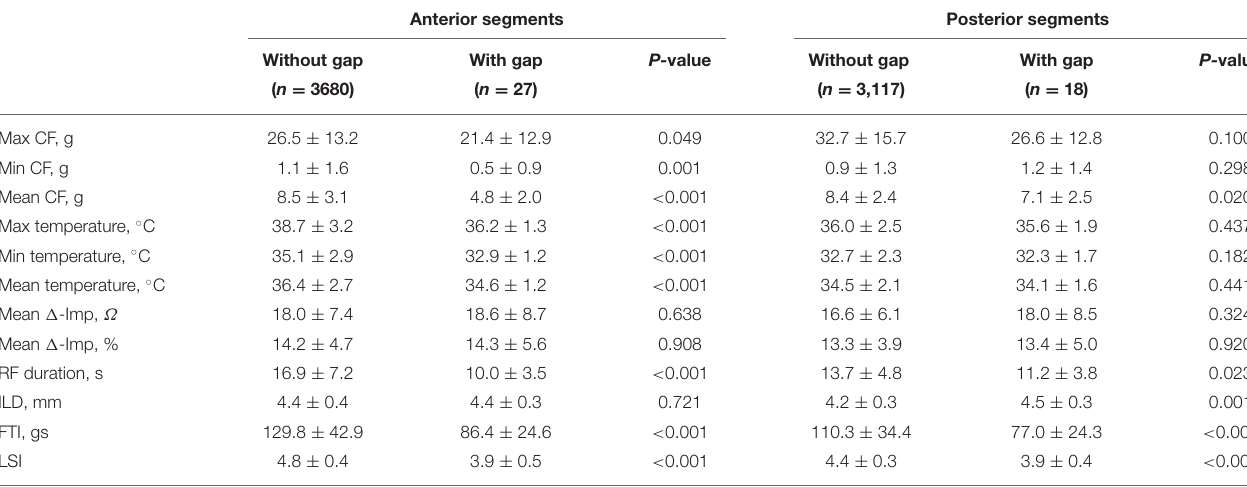
TABLE 4 | Comparison of ablation lesion characteristics of anterior and posterior segments with and without gaps. Anterior segments